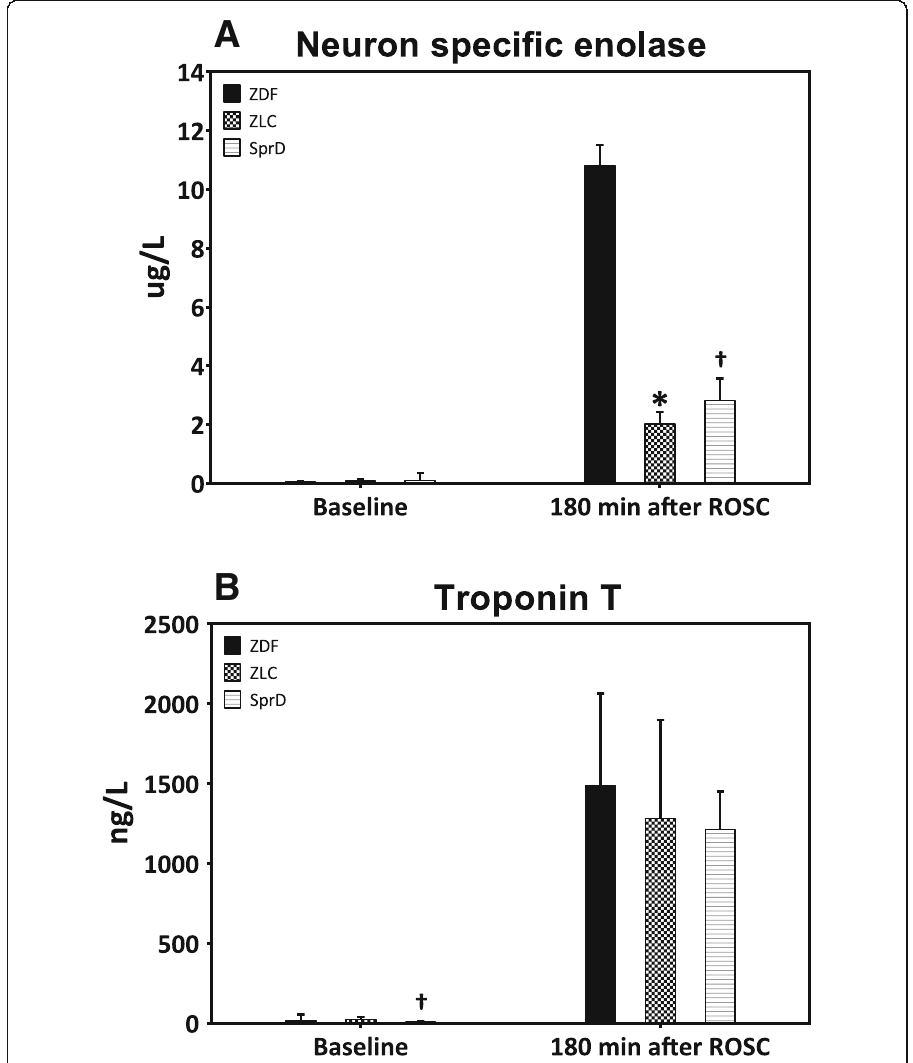
Fig. 2 Neuron-specific enolase and troponin T. a Neuron-specific enolase values at baseline and 180 min after ROSC. Data are presented as median and associated quartiles (Q 25 and Q 75 ). Number of animals: ZDF ( n = 10), ZLC ( n = 6), and SprD ( n = 8). b Troponin T values at baseline and 180 min after ROSC. Data are presented as mean and SD. Number of animals: ZDF ( n =11, one missing data point at 180 min after ROSC), ZLC ( n =6), and SprD ( n =8). For both analyses, only the animals achieving ROSC are included. * p <0.05 ZDF vs. ZLC; † p <0.05 ZDF vs. SprD. ROSC: return of spontaneous circulation, ZDF: Zucker diabetic fatty group, ZLC: Zucker lean control group, SprD: Sprague Dawley